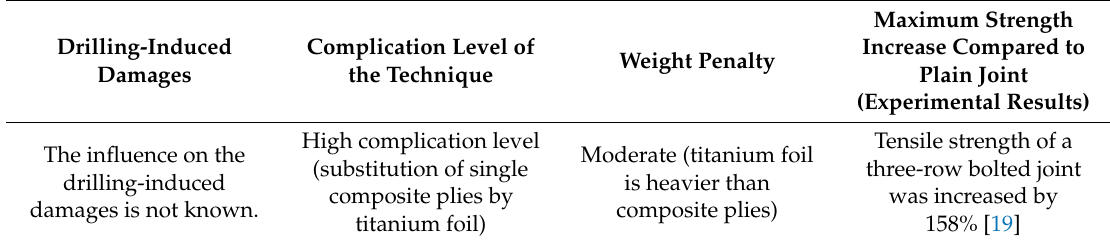
Table 2. Summary of titanium foil inserts e ff ect on performance of bolted joints in composite materials.